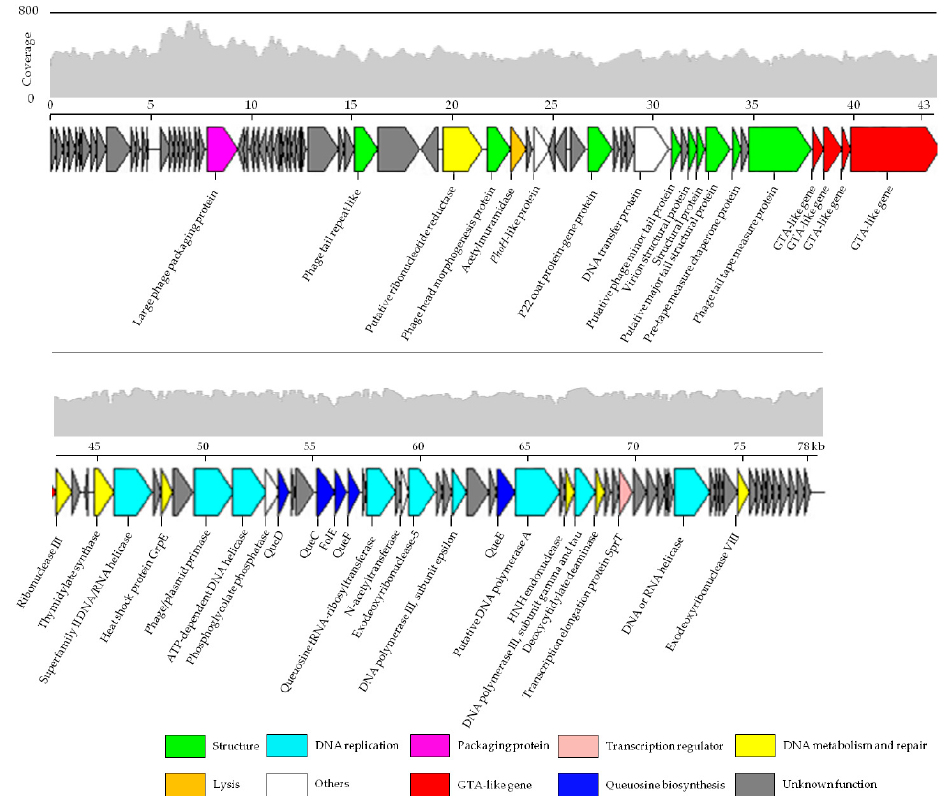
Figure 3. Genome map of the roseophage R5C. ORFs are depicted by leftward or rightward oriented arrows according to the direction of transcription. Gene features and genome modules (structure, lysis and DNA replication) are color-coded according to the legend below the figure.